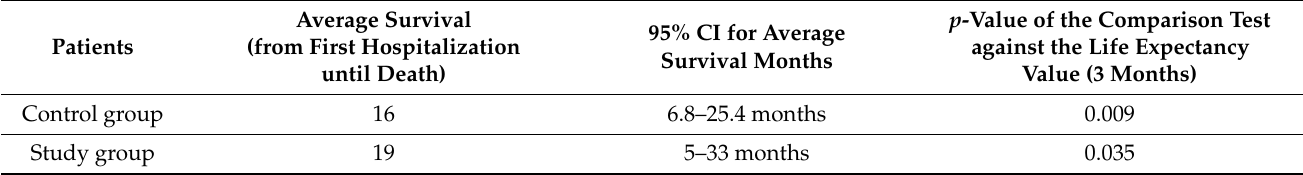
Table 1. Survival rates from study inclusion.